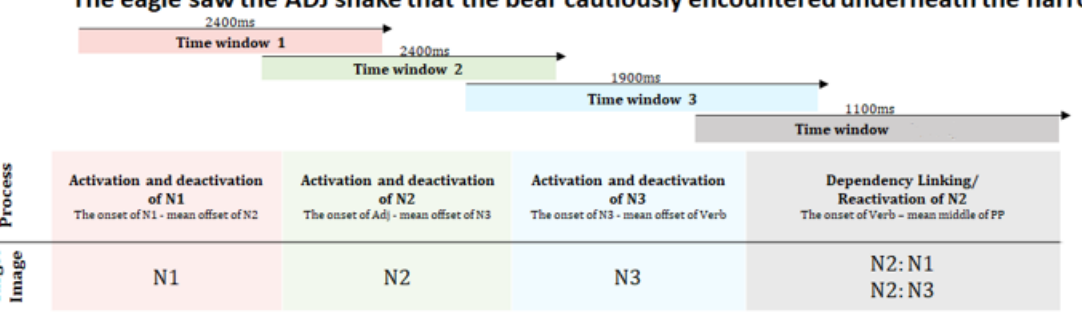
Figure 4. Mean gaze over time toward N1 (first noun, solid salmon line), N2 (second noun, solid green line), N3 (third noun, solid blue line), and a distractor image (solid purple line) averaged across conditions for each group which begins at the auditory onset of the sentence (N1), N4 (unre- lated noun, purple line). Shaded areas represent 95% confidence intervals within subject. The dotted